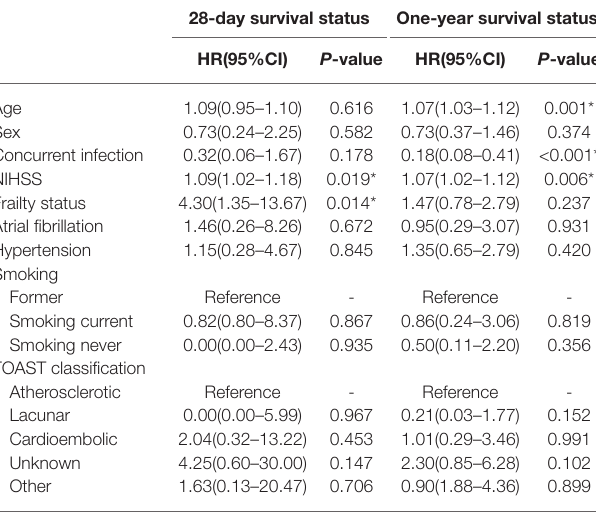
TABLE 3 | Cox regression for 28-day and 1-year follow-up survival status for survival analysis.